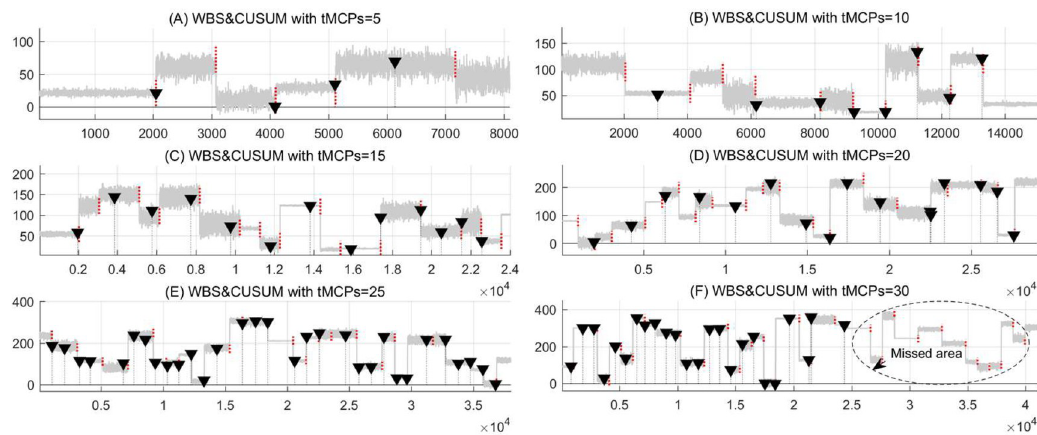
Fig 7. The simulations of MCPs detection under different numbers of t MCPs in the WBS&CUSUM method. For the synthetic time series with different t MCPs from 5 to 30, the results of MCPs detection are presented as (A) t MCPs = 5, (B) t MCPs = 10, (C) t MCPs = 15, (D) t MCPs = 20, (E) t MCPs = 25, and (F) t MCPs = 30, respectively.